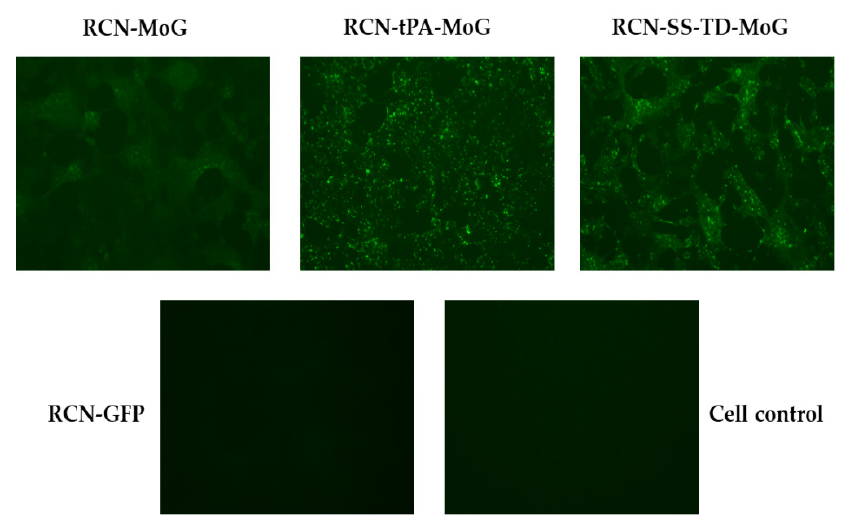
Figure 2. Immunofluorescence of raccoonpox constructs RCN-MoG, RCN-tPA-MoG, and RCN-SS- TD-MoG expressing mosaic lyssavirus phylogroup I glycoprotein (MoG) 24 hours after infection. RCN expressing green fluorescent protein (GFP) and a well of uninfected cells (Cell control) were used as negative controls.